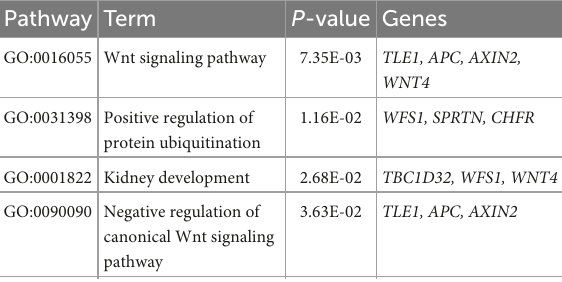
with accelerated aging) selected from the training population ( Figure 2 ). The results together indicate that candidate loci have contributed a significant proportion of the marked difference in the rate of vascular